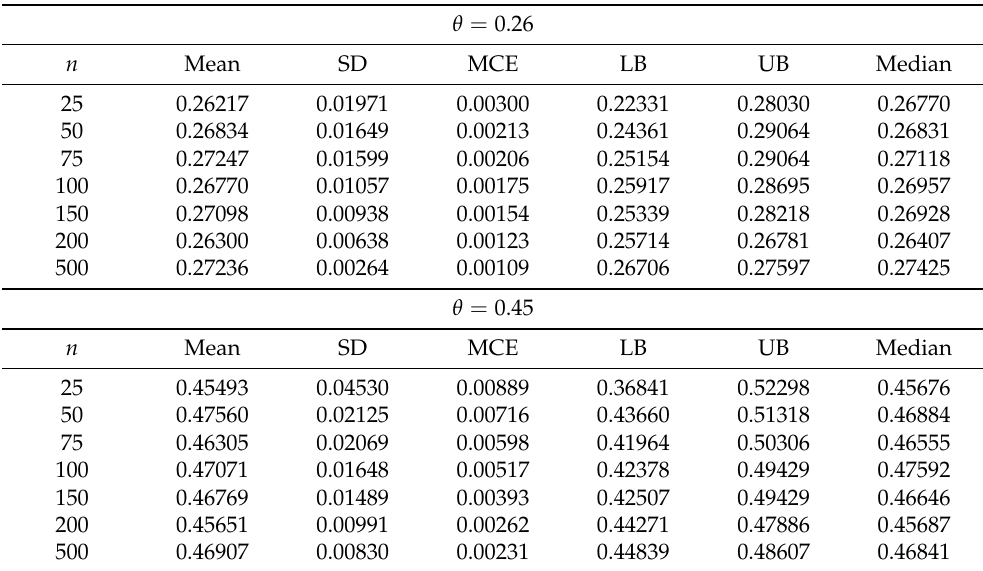
Table 4. Posterior summary results (Case 1: θ ∼ HC ( 25 ) ).